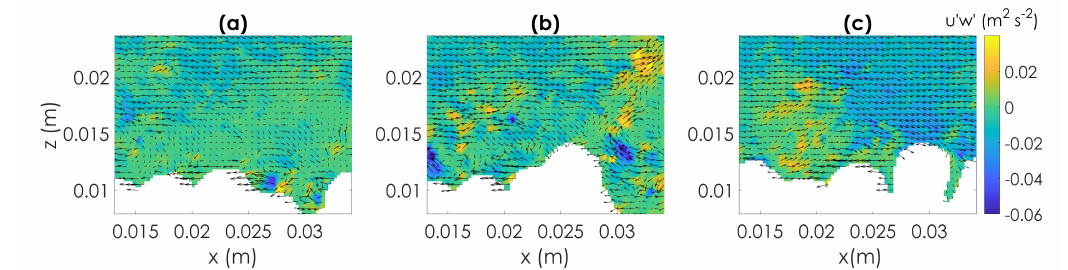
Figure 14. Instantaneous Reynolds shear stress maps with vectors superimposed representing velocity fluctuations obtained for Type B (Particle 3, Test T2) for the sequence of three PIV images reported in Figure 13. (For clarity only 1 out of 2 vectors are depicted.) ( a ) Instantaneous Reynolds stresses around particle at rest. ( b ) Flow disturbed by passing-by particle. ( c ) Instantaneous Reynolds stresses at the moment particle at rest is entrained.